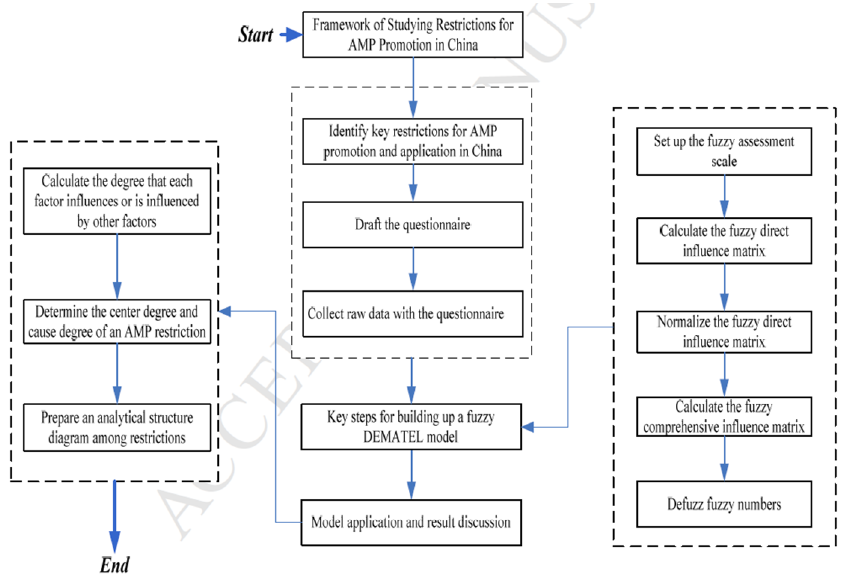
Figure 25. Flowchart of a Cold Ironing implementation process. Reprinted with permission from ref. [118]. Copyright © 2018 Elsevier Ltd. All rights reserved.